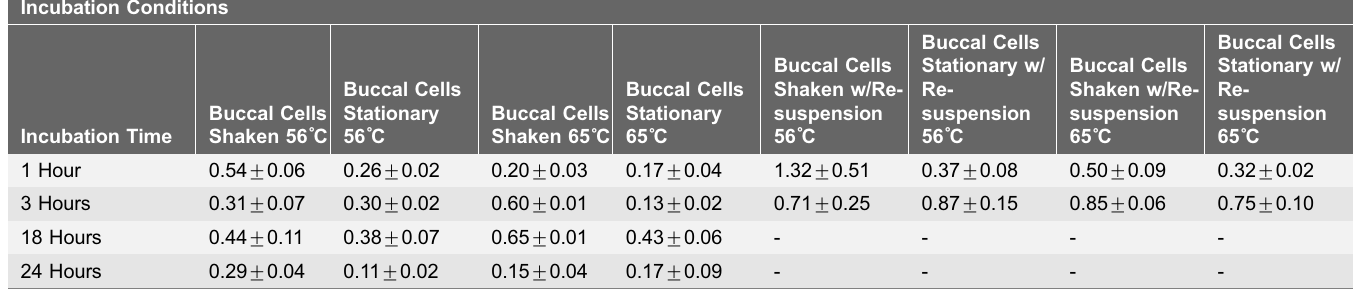
Table 2. Average DNA quantitation values 1 for experiments with buccal